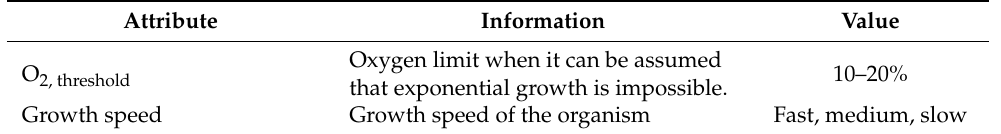
Table 1. Information stored in the recipe. The values of the individual attributes may differ from organism to organism, especially if the cultivation time varies